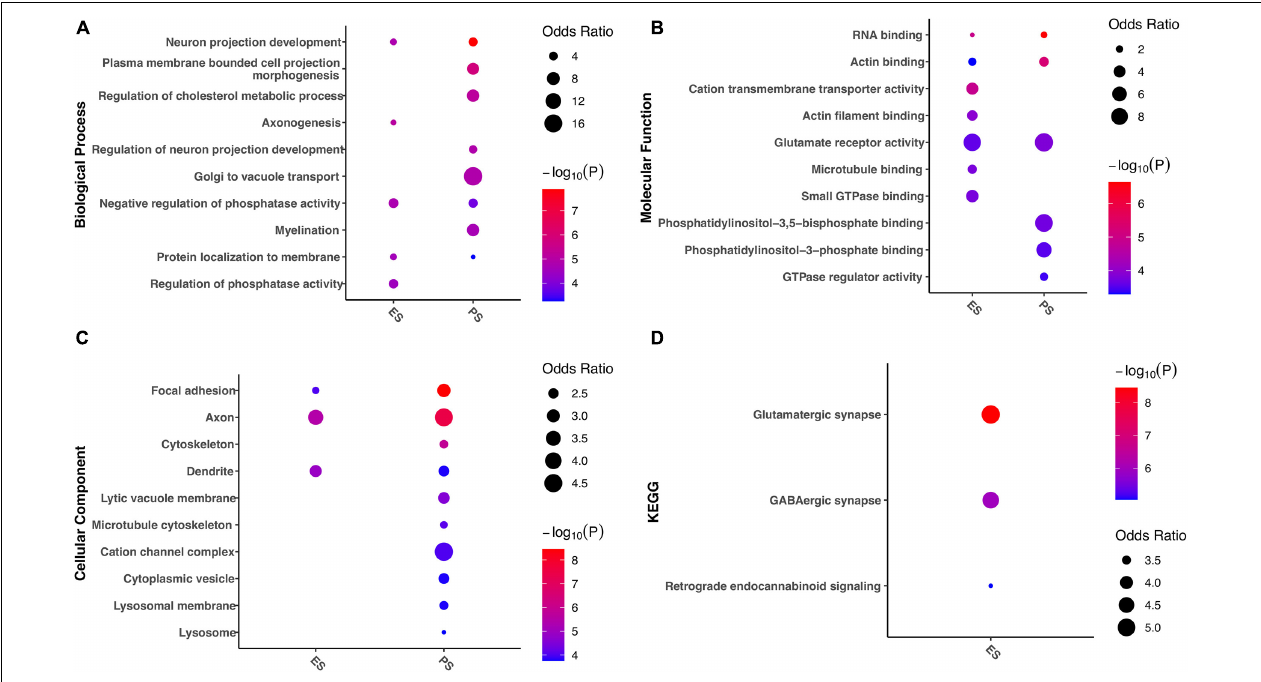
FIGURE 9 | Gene ontology and KEGG pathways associated with divergent G-to-A RNA editing patterns between PS and ES. The items with the most significant P -values are shown for (A) biological processes, (B) molecular functions, and (C) cellular components, as well as (D) KEGG pathways. ES, emotional stress; PS: physical stress.